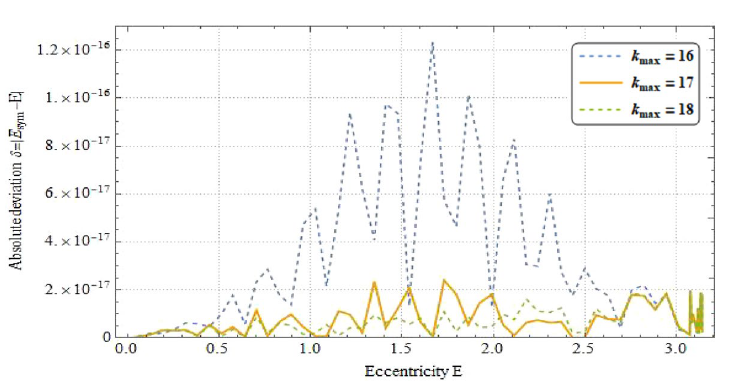
E true − f ( E true − e sin E true ) (cid:31) (cid:31)